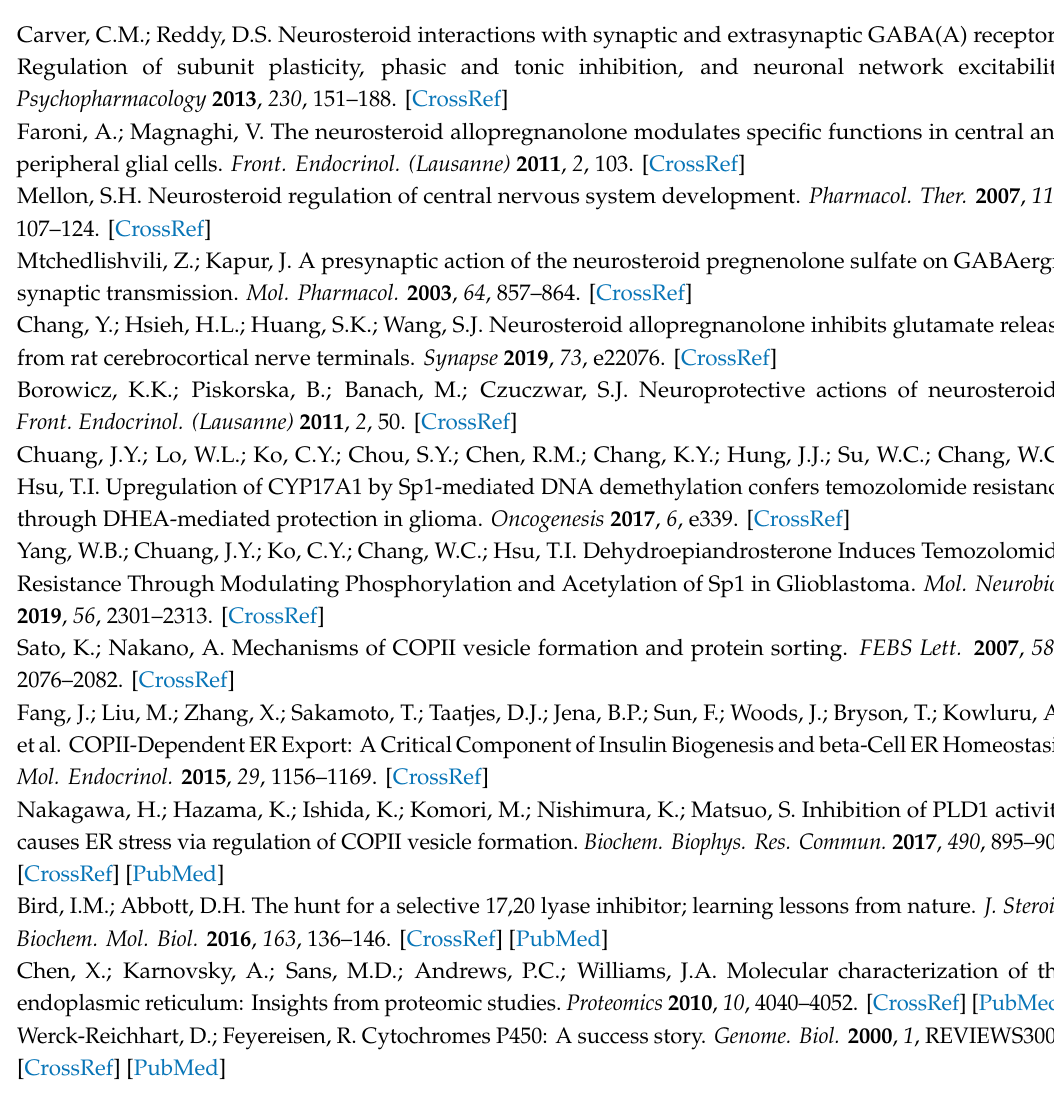
Figure S1: The e ff ect of DDK-CYP17A1 overexpression on DHEA production, Figure S2: DHEA attenuates abiraterone-induced ROS production, Figure S3: E ff ect of DHEA on SAR1a / b expression, Figure S4: E ff ect of abiraterone (A) on mRNA levels of SAR1a / b and SRP14, Supplementary Figure S5: E ff ect of SAR1a on Abi-induced ROS production, Table S1: The antibody list, Table S2: Upregulated proteins by CYP17A1